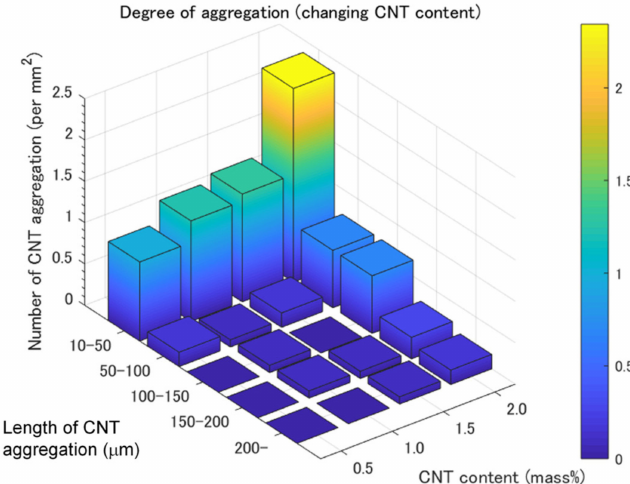
Figure 6. Influence of CNT content on CNT dispersion states (sonication time of 3 h).